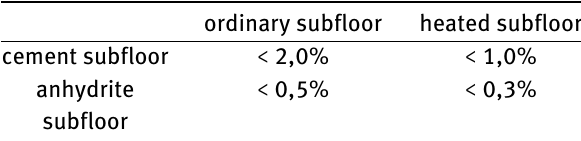
Table 2: Recommended humidity levels of subfloor under wooden